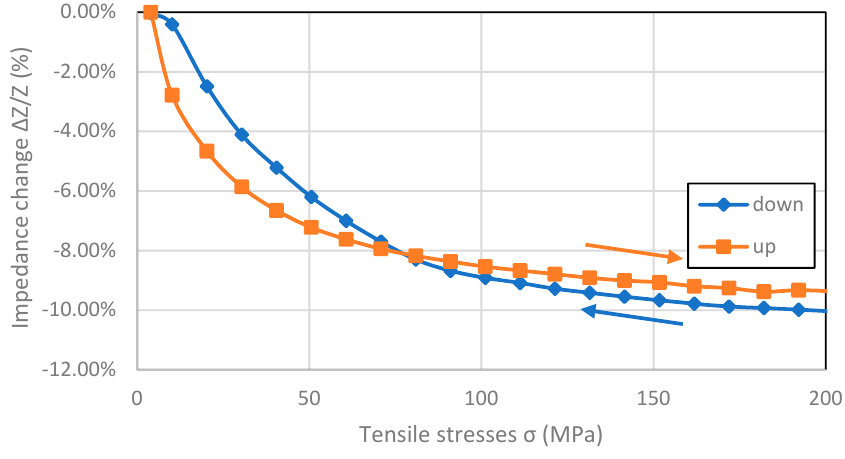
Figure 6. Hysteresis SI measurements of Fe 80 B 11 Si 9 sample (for 1 MHz driving signal).